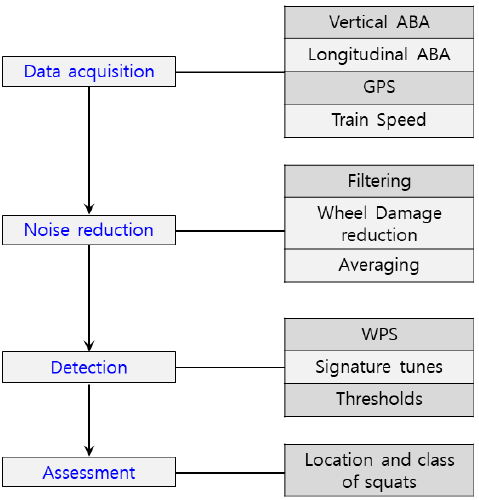
Figure 4. Detection procedure .